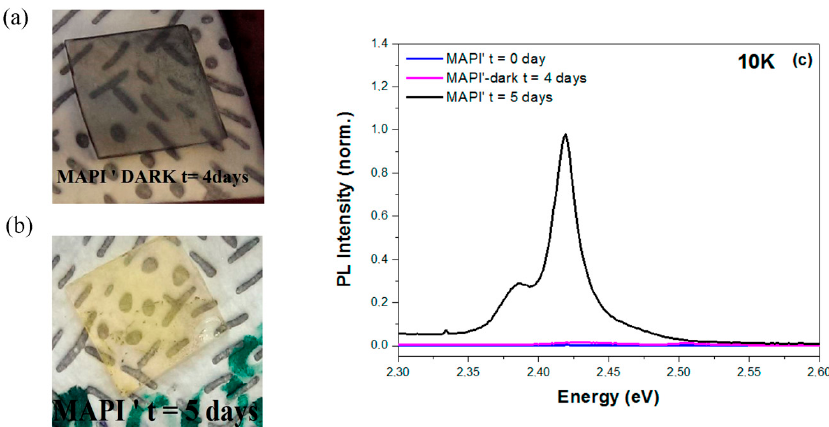
Figure 7. Photographs of ( a ) a 800 nm thick MAPI layer stored in a dark box at t = 4 days; ( b ) a 800 thick MAPI layer stored in a transparent box, at t = 5 days; ( c ) PL spectra (excitation at 3.815 eV) in the 2.3–2.6 eV range for MAPI layer in the dark box at t = 4 days (MAPI’-dark), MAPI layer in the transparent box (MAPI’) at t = 5 days. The PL spectra have been normalized so that the maximum PL at 1.64 eV is 1 (I 1.64 eV = 1).